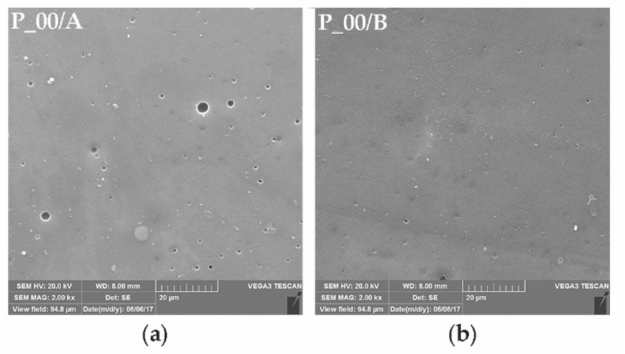
Figure 4. SEM micrographs of paper-adhesive samples for A and B paper with PVAc adhesive (magnification 2000 × ). ( a ) P_00 / A; ( b ) P_00 /